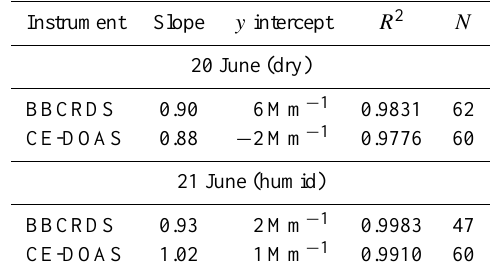
Table 4. Summary of the correlations of the aerosol extinction co- efficients retrieved by BBCRDS and CE-DOAS against that from the IBBCEAS measurements. Data were averaged over the SMPS sampling time. Instrument